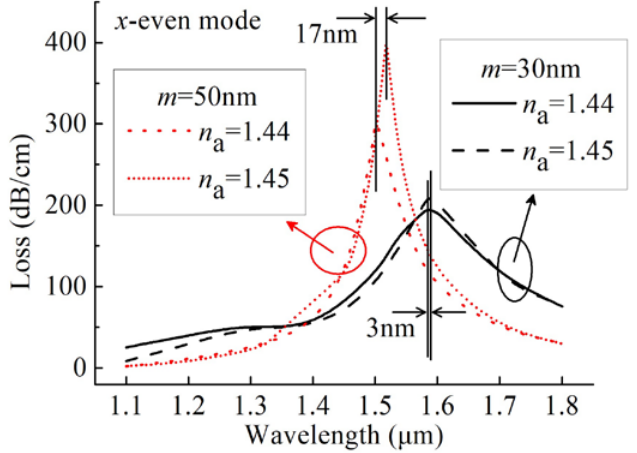
Figure 6. Loss spectra of the x -even core modes for the gold film thicknesses of 30 and 50 nm at n a of 1.44 and 1.45.